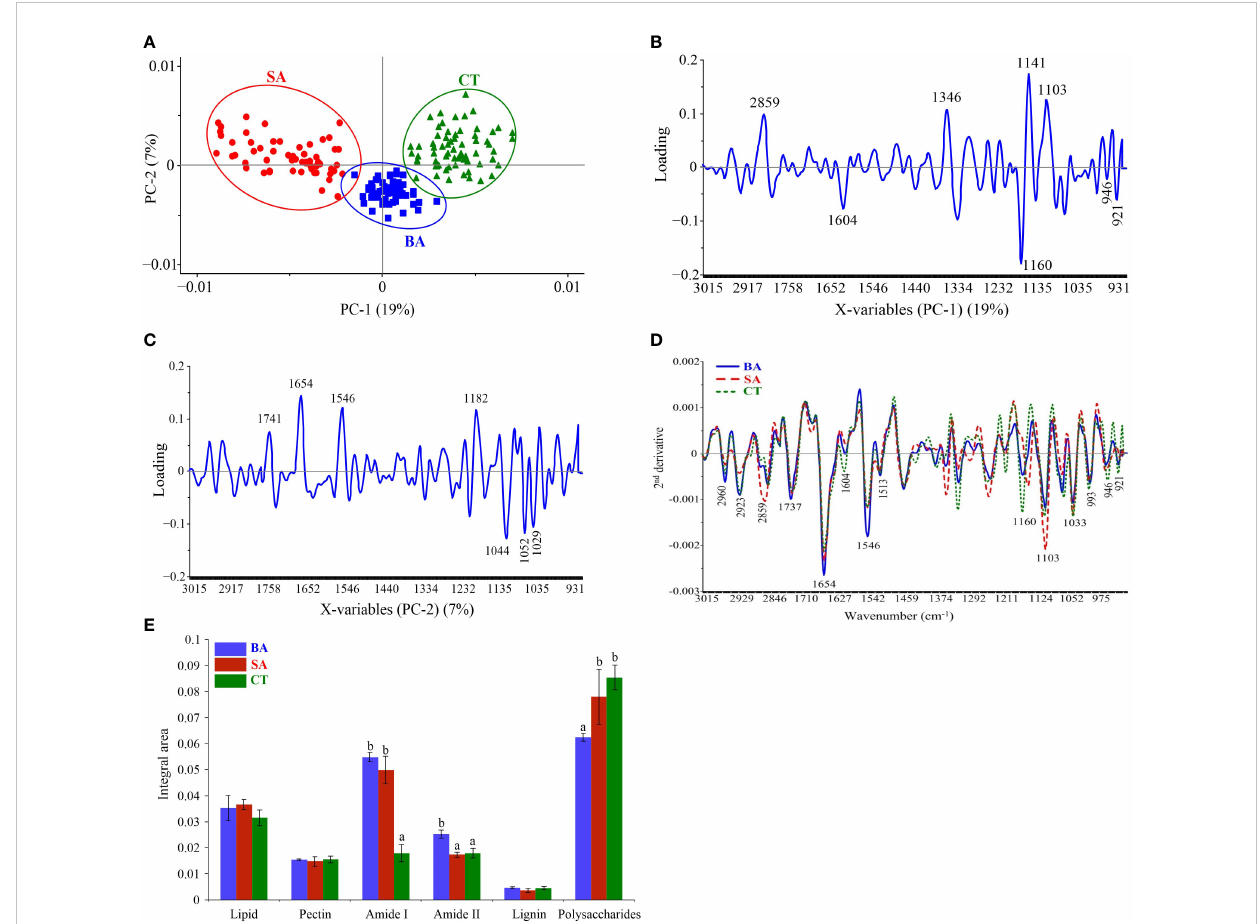
FIGURE 8 SR-FT-IR spectra of mesophyll in rice leaf tissue. (A) Principal component analysis (PCA). (B) Loading plots from PCA analysis (PC1). (C) Loading plots from PCA analysis (PC2). (D) Overlay of the average second derivative spectrum. (E) Integral areas of absorbance between 3,000 and 900 cm -1 Means in the graph followed by different letters are signi fi cantly different according to DMRT at p = 0.05. BA, Bacillus vallismortis – treated sample; SA, salicylic acid – treated sample; CT, control water – treated